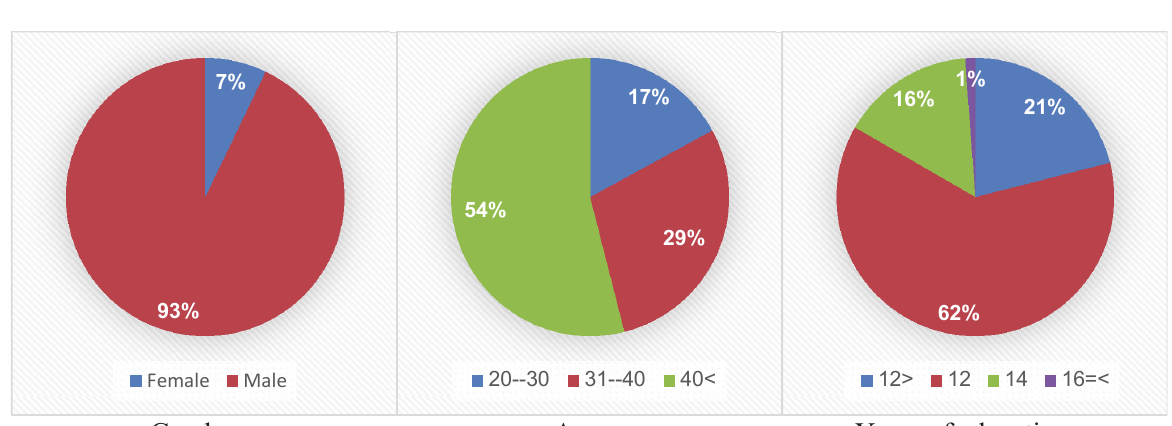
Fig. 1. Personal characteristics of the